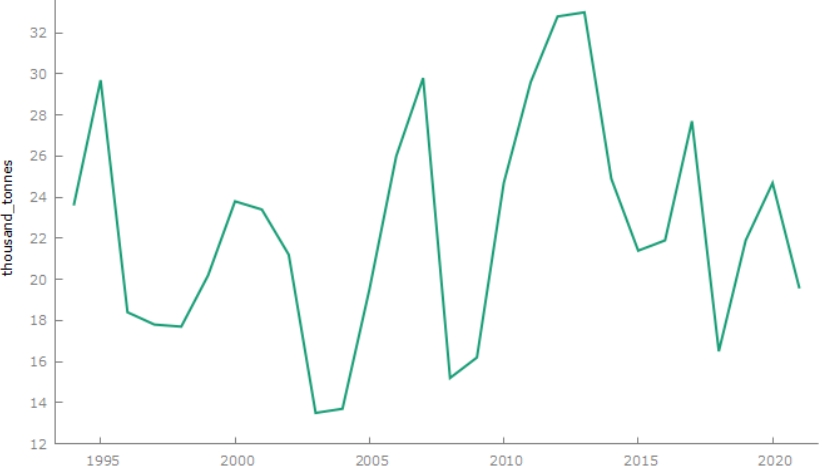
Figure 1. Amount of wild mushrooms harvested in Czech forests between 1994 and 2021.